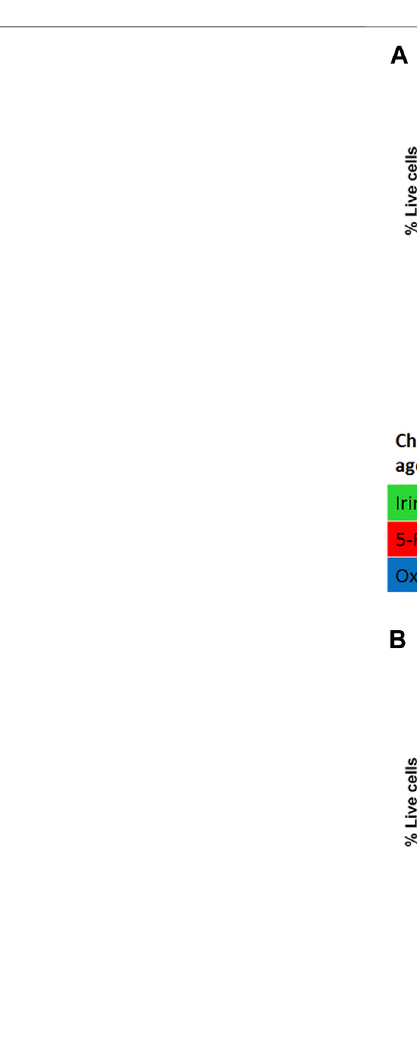
FIGURE 3 | Drug response in 2D cells vs 3D bioprinted cells. (A) Response of Caco-2 cells grown in monolayers (2D) to different concentrations of irinotecan, 5- fl uoruracil (5-FU), and oxaliplatin as annotated and a summary table of the respective IC 50 values. Cells were seeded and treated on the next day with the inhibitors for 72 h. Cell viability was measured with the MTT test, and IC 50 values were calculated from at least 2 biological replicates in technical triplicates. IC 50 values and 95% con fi denceintervalvaluesareboth inug/ml. (B) Responseof3Dbioprintedcells(biologicalduplicatesintechnicalduplicates)to4concentrationsofthe3inhibitors asannotated.Caco-2cellswerebioprinted(asdescribedinMethods)andgrownfor2 weekspriortodrugtreatment.ErrorbarsrepresentmeanwithSD.* p ≤ 0.05,** p ≤ 0.005, *** p < 0.0005, and **** p < 0.0001, ns: not signi fi cant, Student ’ s t -test. Asterisk symbols immediately above error bars indicate signi fi cance compared to control samples; lines with symbols show signi fi cance between the relevant treatment